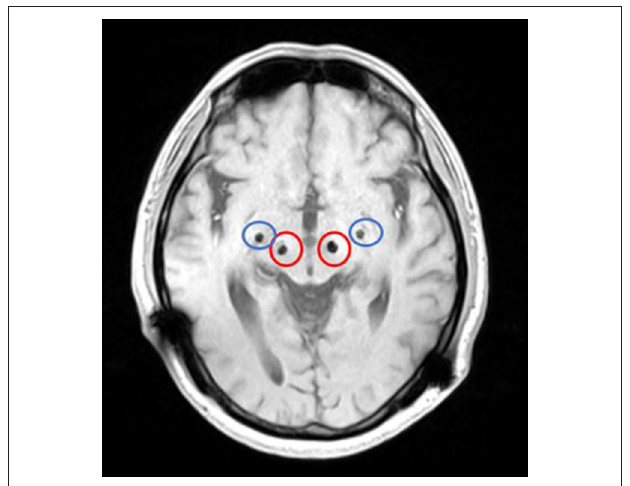
FIGURE 2 | MRI (magnetic resonance imaging) after bSCG-DBS implantation (the red circle is STN, and the blue circle is GPi).